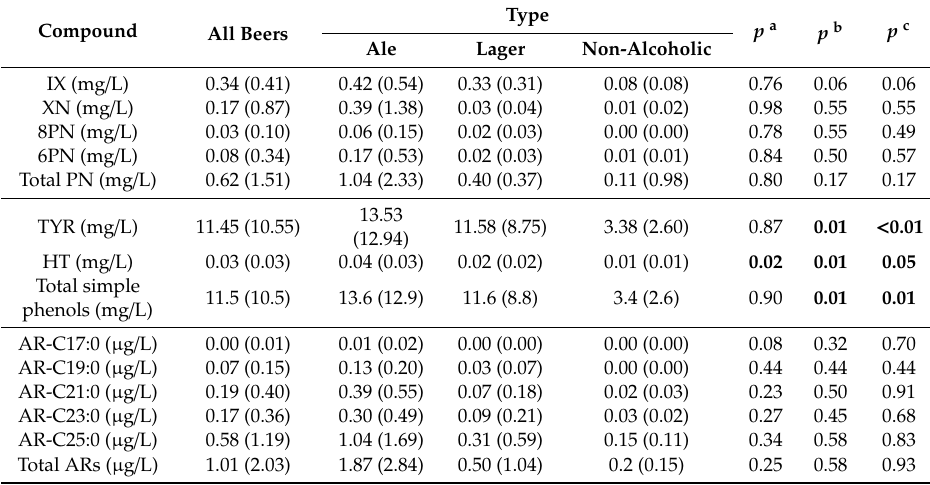
Table 1. Beer phenolic composition of prenylated flavonoids, simple phenols tyrosol (TYR)